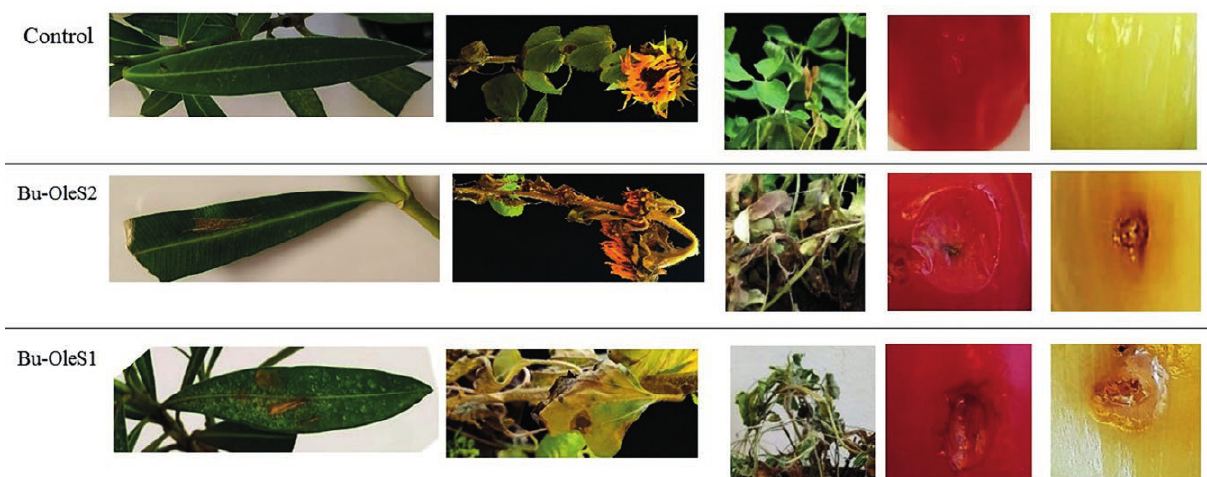
Figure 3. Results from pathogenicity tests for different plants, from inoculation controls (upper row), or plants inoculated with two Serratia marcescens isolates (Bu-OleS2 or Bu-OleS1). The first column shows oleander leaves on the day of inoculation, the second and third columns show sunflower and alfalfa plants, the fourth and fifth columns show bell pepper fruit and onion bulbs at 5 to 6 d